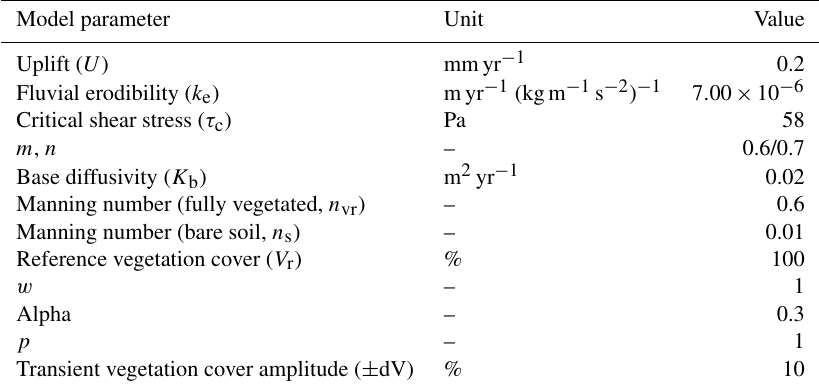
Table 1. Model parameters used for the Landlab model